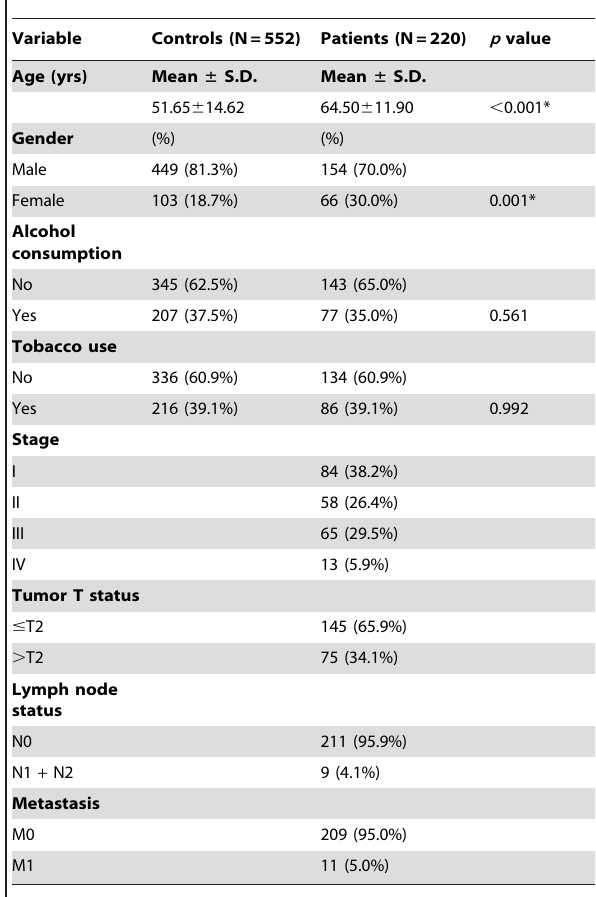
Table 1. Demographic characteristics of controls and patients with